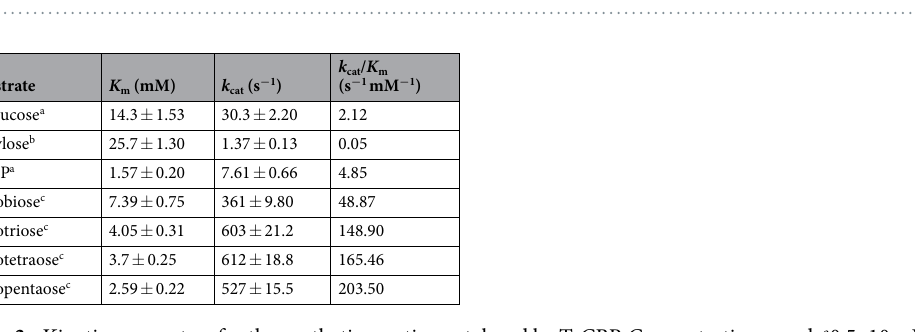
Table 3. Kinetic parameters for the synthetic reaction catalyzed by TaCBP. Concentrations used: a 0.5–10 mM; b 5–100 mM; c 0.5–5 mM.